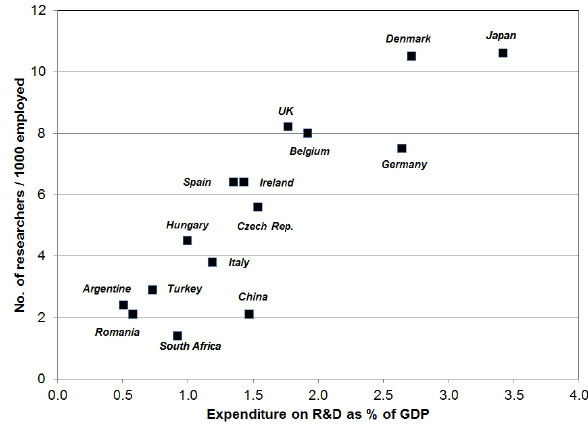
Fig. 2. Comparison of expenditure on R&D and number of re- searchers (in all fields) based on 2008 data presented in Blankley and Booyens